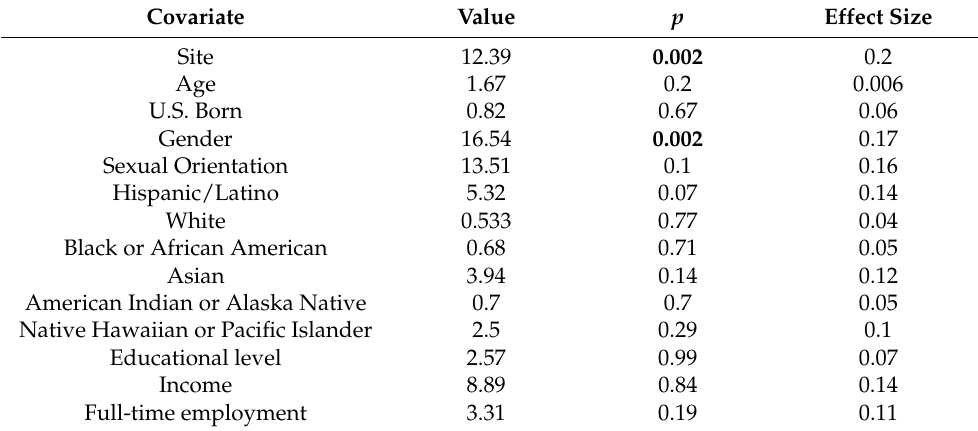
Table 2. Test results of profile membership by demographic outcome. Covariate Value p Effect